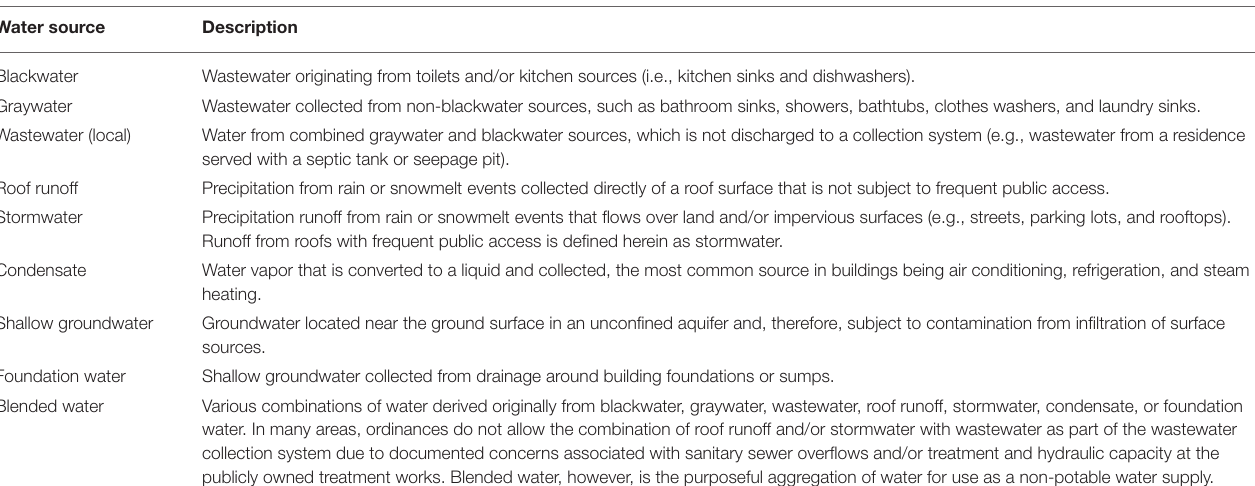
TABLE 3 | Other potential water sources for reclamation and reuse a